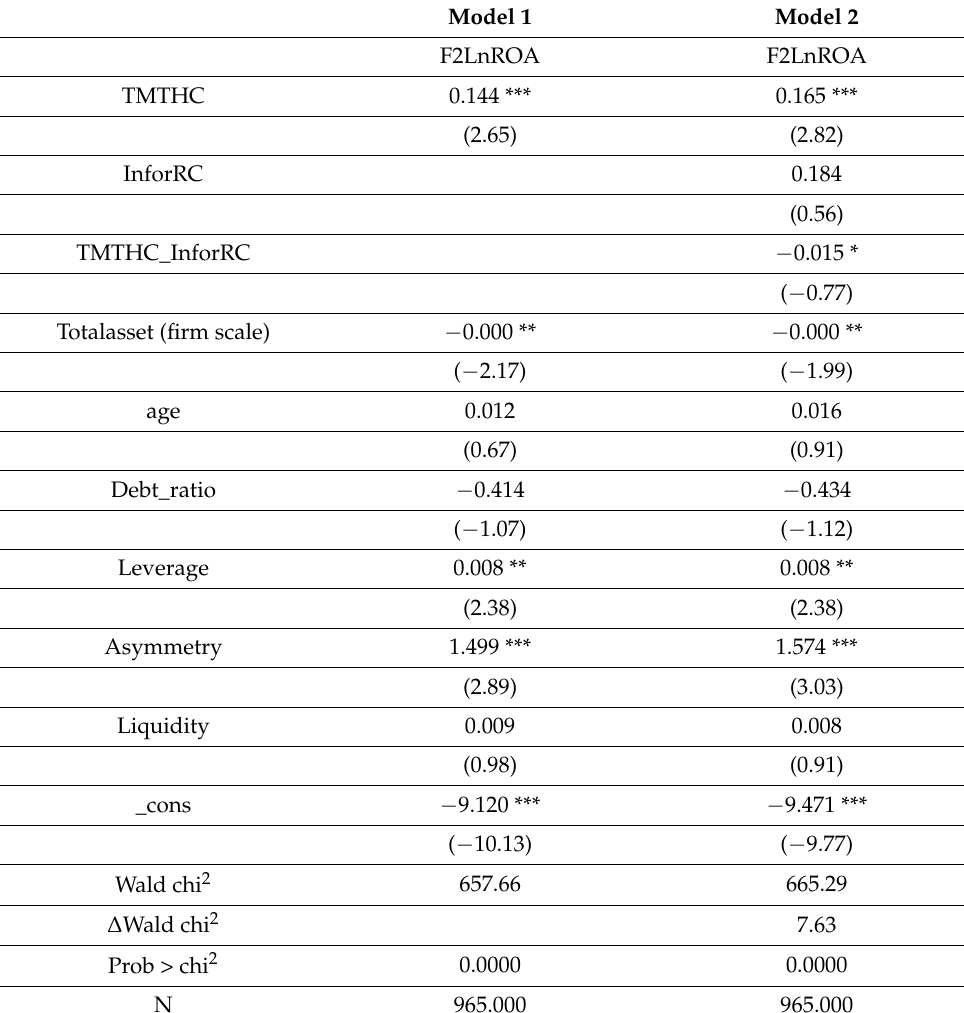
Table A1. Results of the panel regression with random